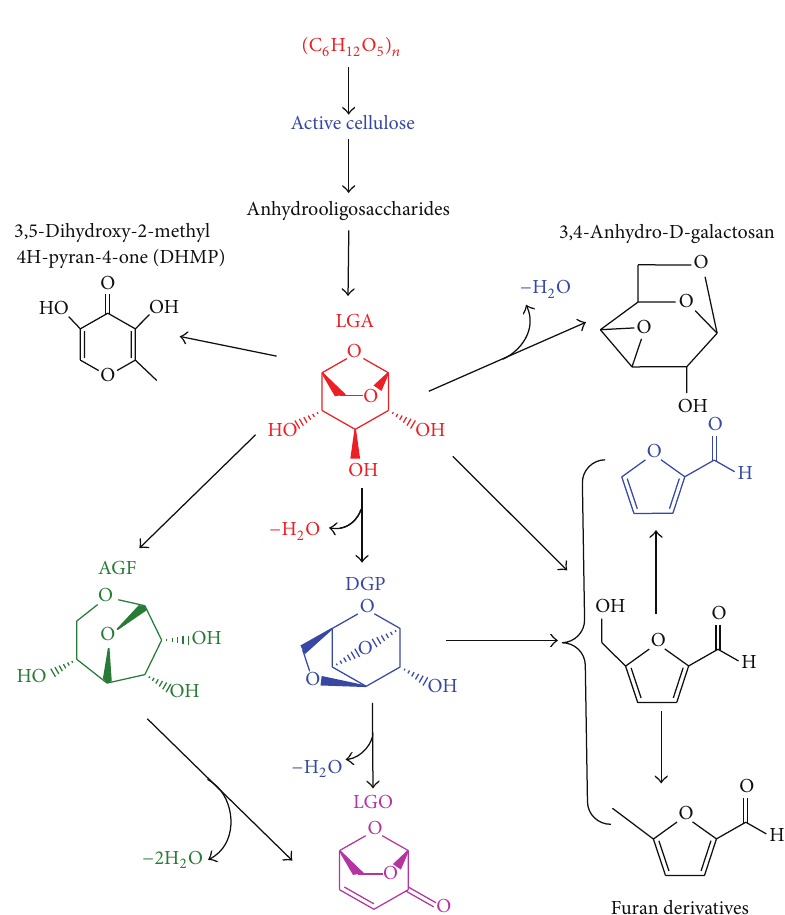
Figure 9: The possible conversion pathways of cellulose